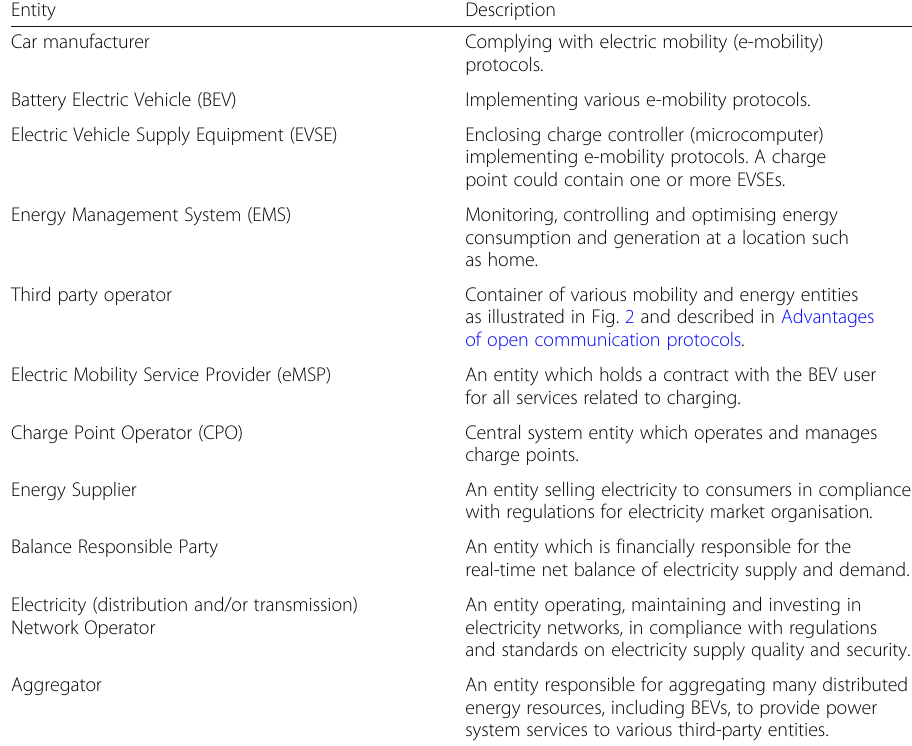
Table 1 Description of EV ecosystem entities as illustrated in Fig. 2 Entity